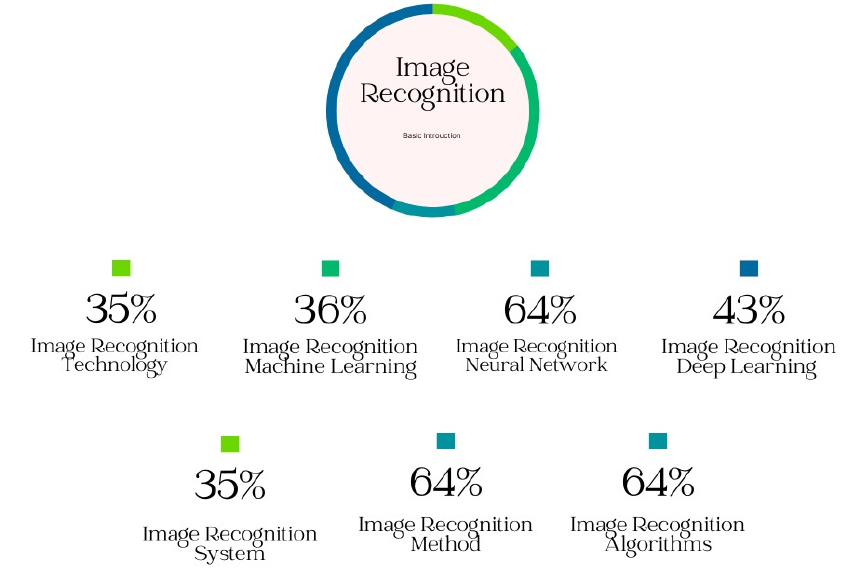
Figure 8. Details of the next eight